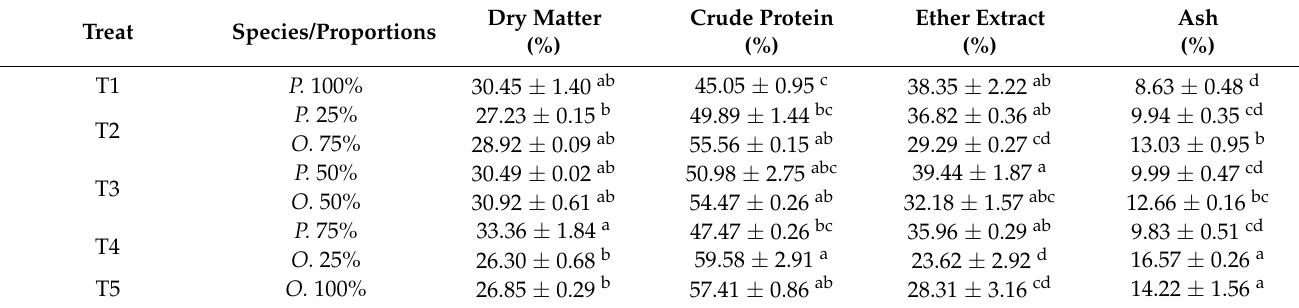
Table 5. Whole-body proximate chemical composition of juvenile striped catfish, Pangasianodon hypophthalmus (P.), and Nile tilapia, Oreochromis niloticus (O.), reared in monoculture and different polyculture compositions for 14 weeks ( n = 3; means ±